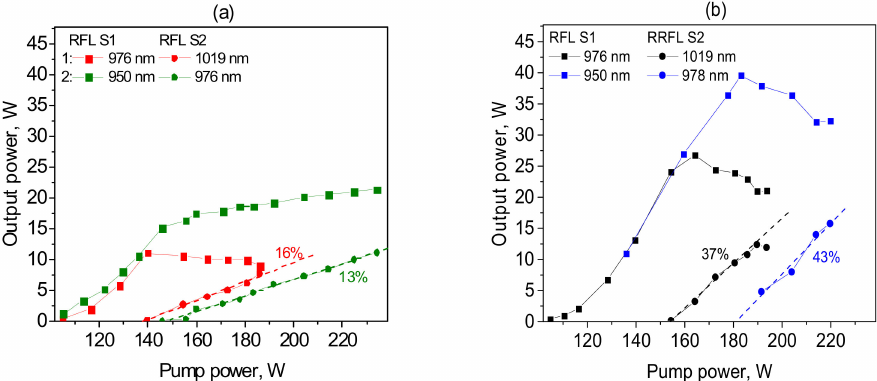
Figure 3. Output power in linear RFL cavity ( a ) and half-open random RFL (RRFL) cavity ( b ) for the 2nd Stokes wave (S2) while 1st Stokes (S1) has linear RFL cavity in two different configurations: (1) 940 nm LD pumping and 976/1019 nm S1/S2 cavity; (2) 915 nm LD pumping and 950/978 nm S1/S2 cavity,